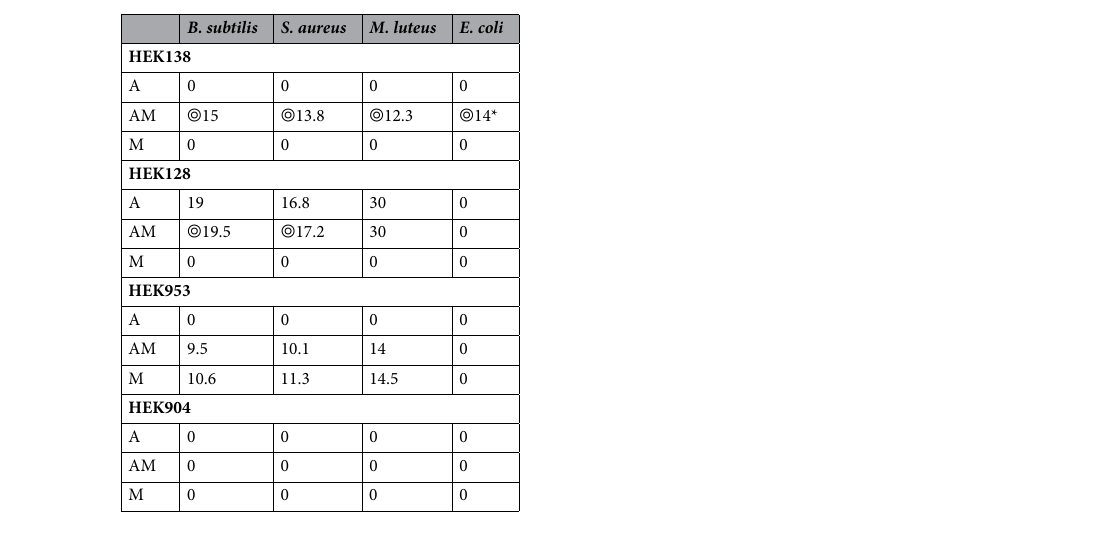
Table 2. Paper disc assay. Clearance zones of Gram-positive Bacillus subtilis ATCC6633, Staphylococcus aureus 209PJC-1, Micrococcus luteus ATCC9341, and Gram-negative Escherichia coli NIHJ-2 were determined in response to extracts from culture of the natural pairs in combined-culture. *Indicates the translucent inhibition zone. Double circles indicate the extracts with specific or improved activity by combined-culture. (number = growth inhibition zone,